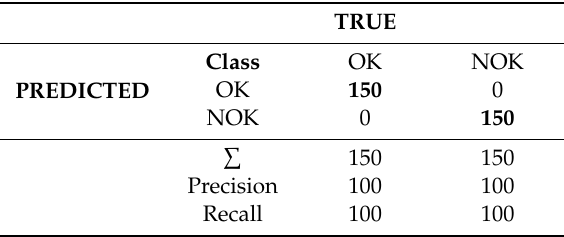
Table 4. Confusion matrix of results for two classes.